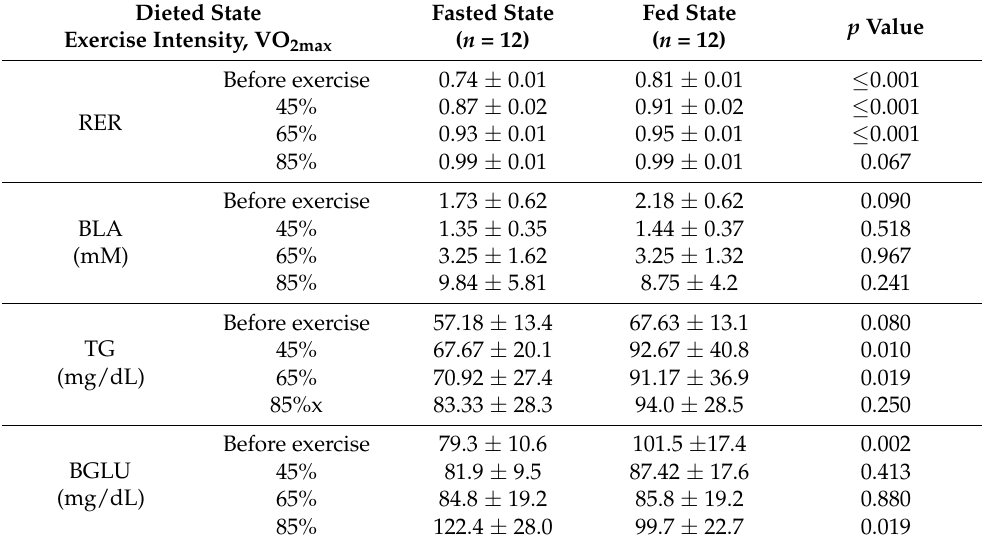
Table 2. Respiratory exchange ratio (RER), blood glucose (BGLU), blood lactate (BLA), and blood triglyceride (TG) values for the fed and fasting state at each intensity. Dieted